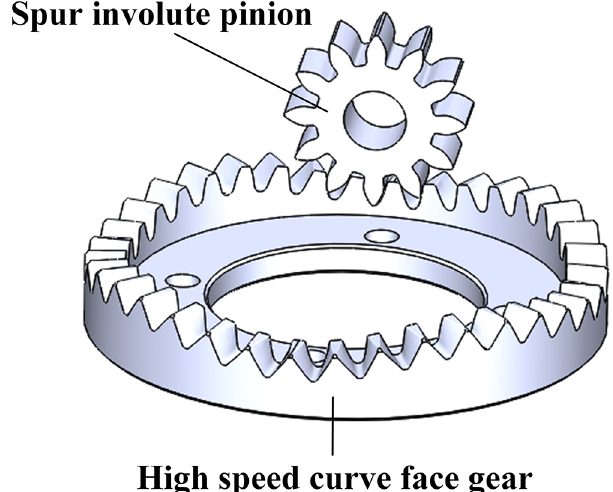
Fig. 1. High speed curve face